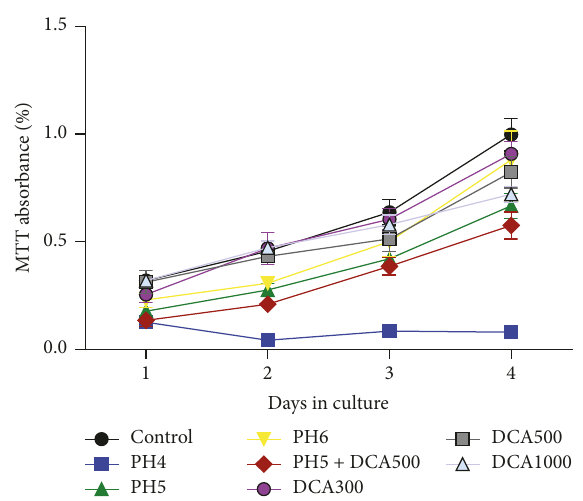
Figure 4: MTT assay was performed to detect cell viability at 24, 48, 72, and 96 h in Het-1A cells with different